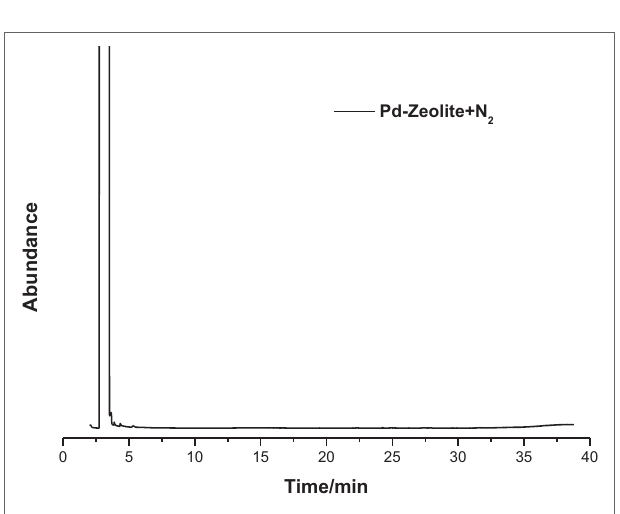
FIGURe 6 | GC–MS spectrum of the products from lignin depolymerization on Pd-zeolite under the N 2 atmosphere.